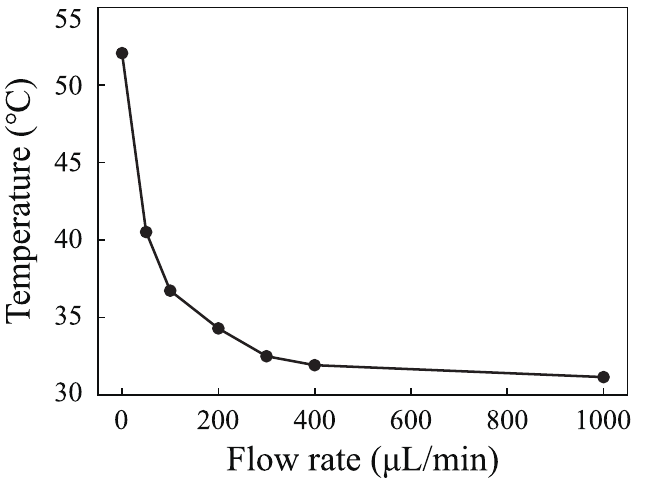
1 , 50 µ L min − · 1 . min − ·